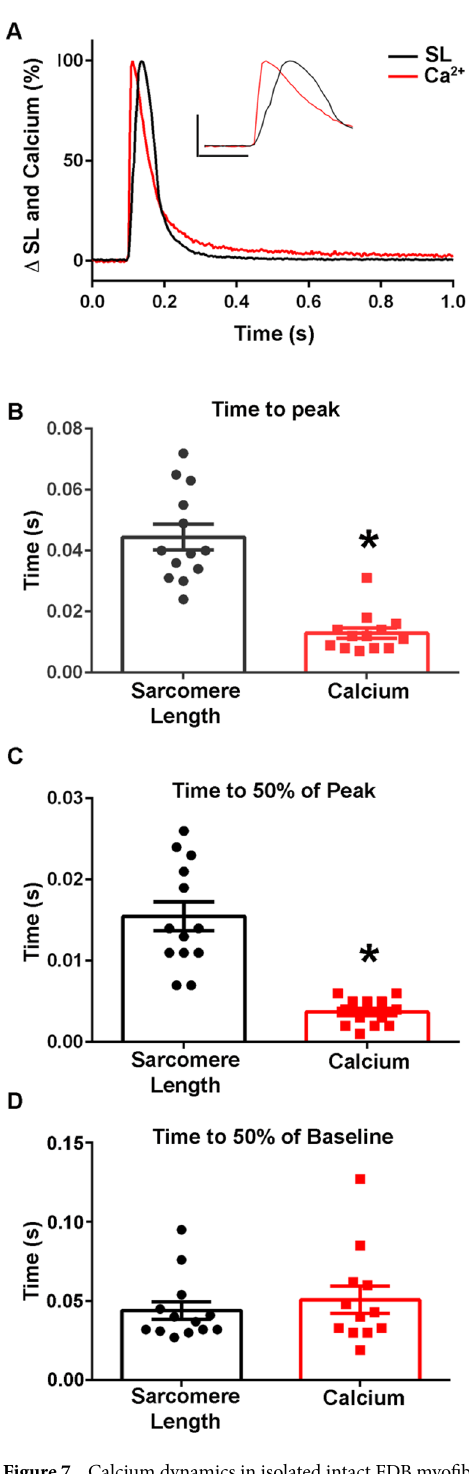
Figure 7. Calcium dynamics in isolated intact FDB myofibers at room temperature. ( A ) Normalized traces (0–100%) of an ensemble average of FURA-2 calcium fluorescence (red) and sarcomere length (black) dynamics showing that the calcium transient time to peak precedes the peak of the sarcomere length transient. Inset shows same data and serves to highlight the differences of the peak timing (y-axis represents a 50% change from baseline, x-axis represents 0.10 s). ( B ) Summary statistics for time to peak for the calcium transient and sarcomere length changes shows peak amplitude of the calcium transient occurs significantly before the peak sarcomere length change (n = 13 myofibers in each group from n = 3 animals). ( C ) Summary statistics for the time to 50% of peak for the calcium transient and sarcomere length demonstrates there is a significant difference between the calcium kinetics (0.0037 ± 0.0005 s) and sarcomere length changes (0.0155 ± 0.0018 s) (n = 13 myofibers in each group from n = 3 animals). ( D ) Summary statistics for the time to 50% of baseline for the calcium transient (0.0508 ± 0.0087 s) and sarcomere length changes (0.0440 ± 0.0056 s) shows there is no significant difference in the recovery dynamics of calcium and sarcomere length relaxation (Sarcomere length: n = 13, FURA-2: n = 12 from n = 3 animals). Myofibers measured at room temperature with 0.2 Hz stimulation. Mean ± S.E.M. are presented, * P <